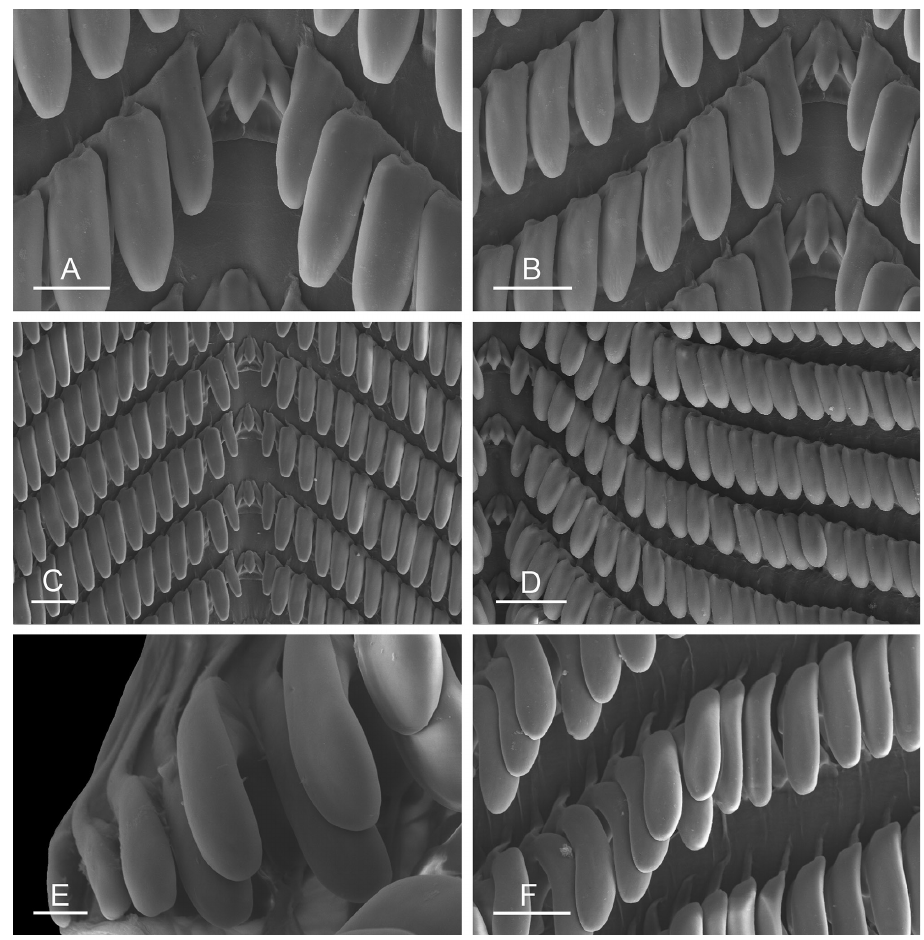
Figure 38. Radula, Wallaconchis ater , Indonesia (A–B) Bali [3137] (UMIZ 00053) (D) Sulawesi [2330] (UMIZ 00039) ( C, E–F ) Sulawesi [2220] (UMIZ 00050). A Rachidian and innermost lateral teeth, scale bar 20 μm B Rachidian and left innermost lateral teeth, scale bar 30 μm C Rachidian and innermost lateral teeth, scale bar 50 μm D Rachidian and right innermost lateral teeth, scale bar 50 μm E Outermost lateral teeth, scale bar 10 μm F Transition between inner lateral teeth and outer lateral teeth, scale bar 40 μm.